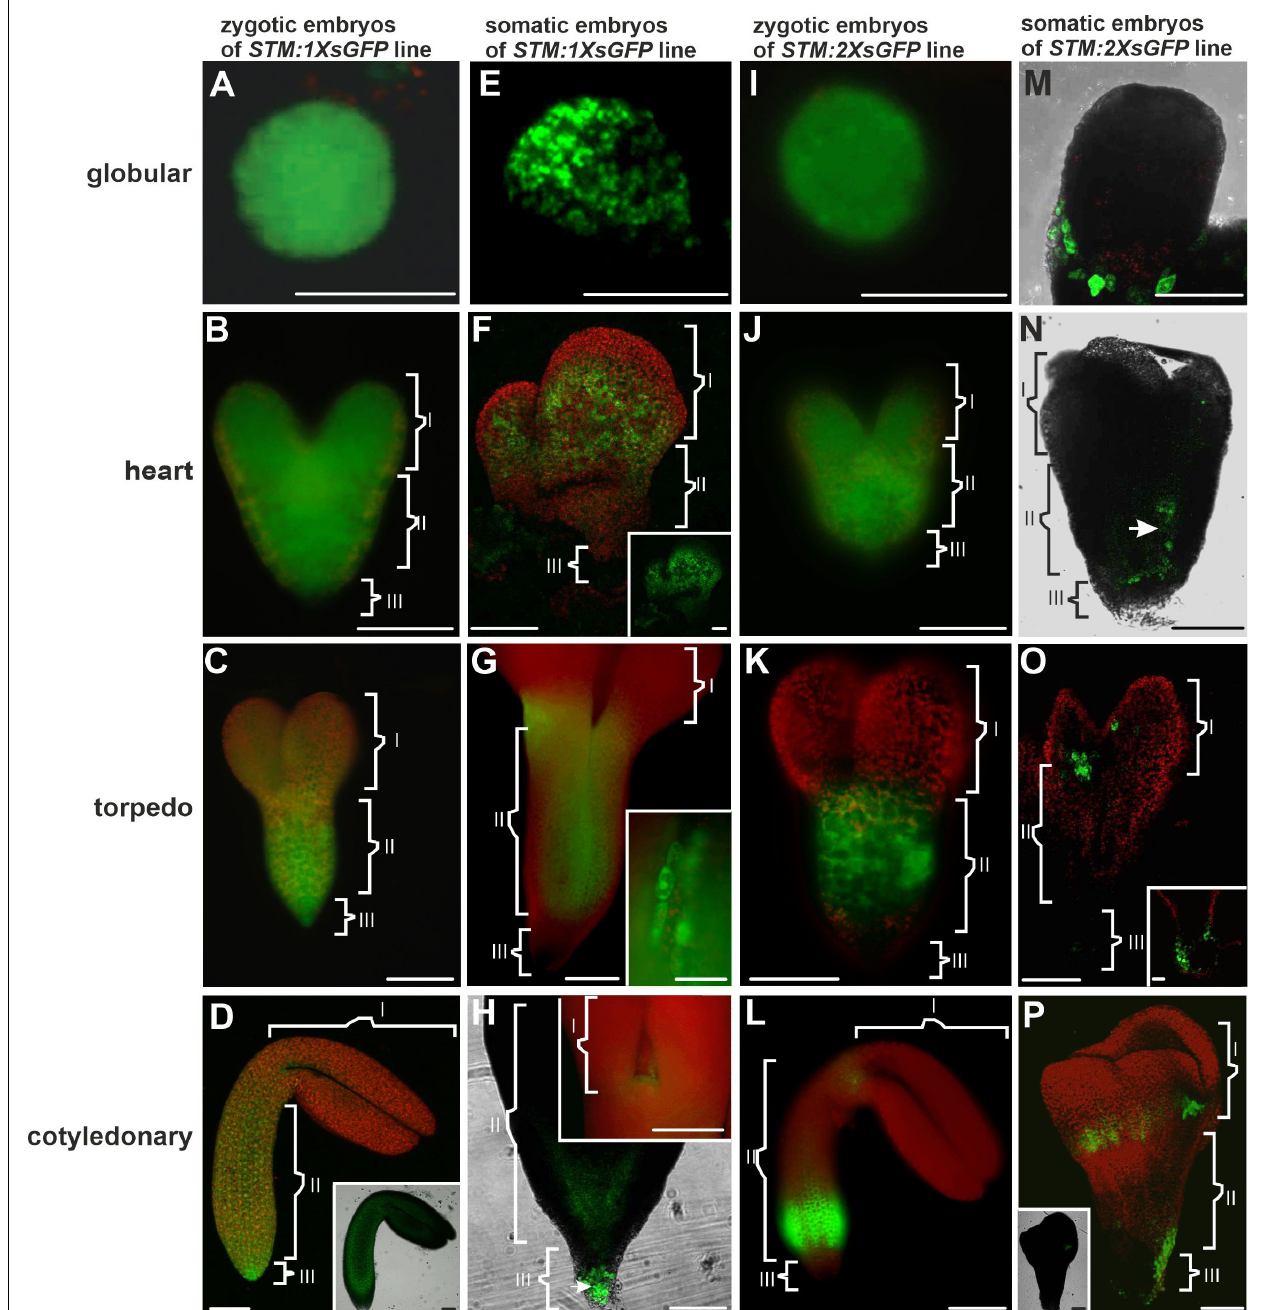
FIGURE 2 | Distribution pattern of the 1XsGFP and 2XsGFP in the ZEs and SEs. Distribution of the 1XsGFP was observed in the entire ZEs at all of the developmental stages: (A) globular, (B) heart, (C) torpedo, and (D) cotyledonary. (D inset) The optical section (CLSM; only GFP channel) shows the 1XsGFP presence in the entire embryo. (E) Globular and (F) heart stages of the SE with the fluorescence of the 1XsGFP. (F inset) The GFP channel. (G) Torpedo stage of the SE. (G inset) The intracellular localization of the GFP. (H) Embryo in the cotyledonary stage. (H inset) The SAM in the embryo in the cotyledonary stage (green fluorescence indicates the presence of the 1XsGFP). (I) Globular, (J) heart, (K) torpedo, and (L) cotyledonary stage of the ZEs (green fluorescence indicates the presence of the 2XsGFP). (M) In the globular SE, the 2XsGFP was not detected. (N) Heart and (O) torpedo SE. (O inset) Basal part of the torpedo SE. (P) Cotyledonary stage of the SE (green fluorescence indicates the presence of the 2XsGFP). (P inset) Optical section through the SE in the cotyledonary stage with fluorescence visible in the SAM cells. ( I, II, and III – description is the same as for Figure 1 ). A–C,E,G,H inset,I–L – images from the epifluorescence microscope; D,D inset, F,H,M,O,P,P inset – images from the CLSM. Scale bars; A,C,D,D inset,E–G,H inset,I,K–O,O inset,P,P inset = 100 µ m; B,J,H = 50 µ m; G inset = 10 µ m.